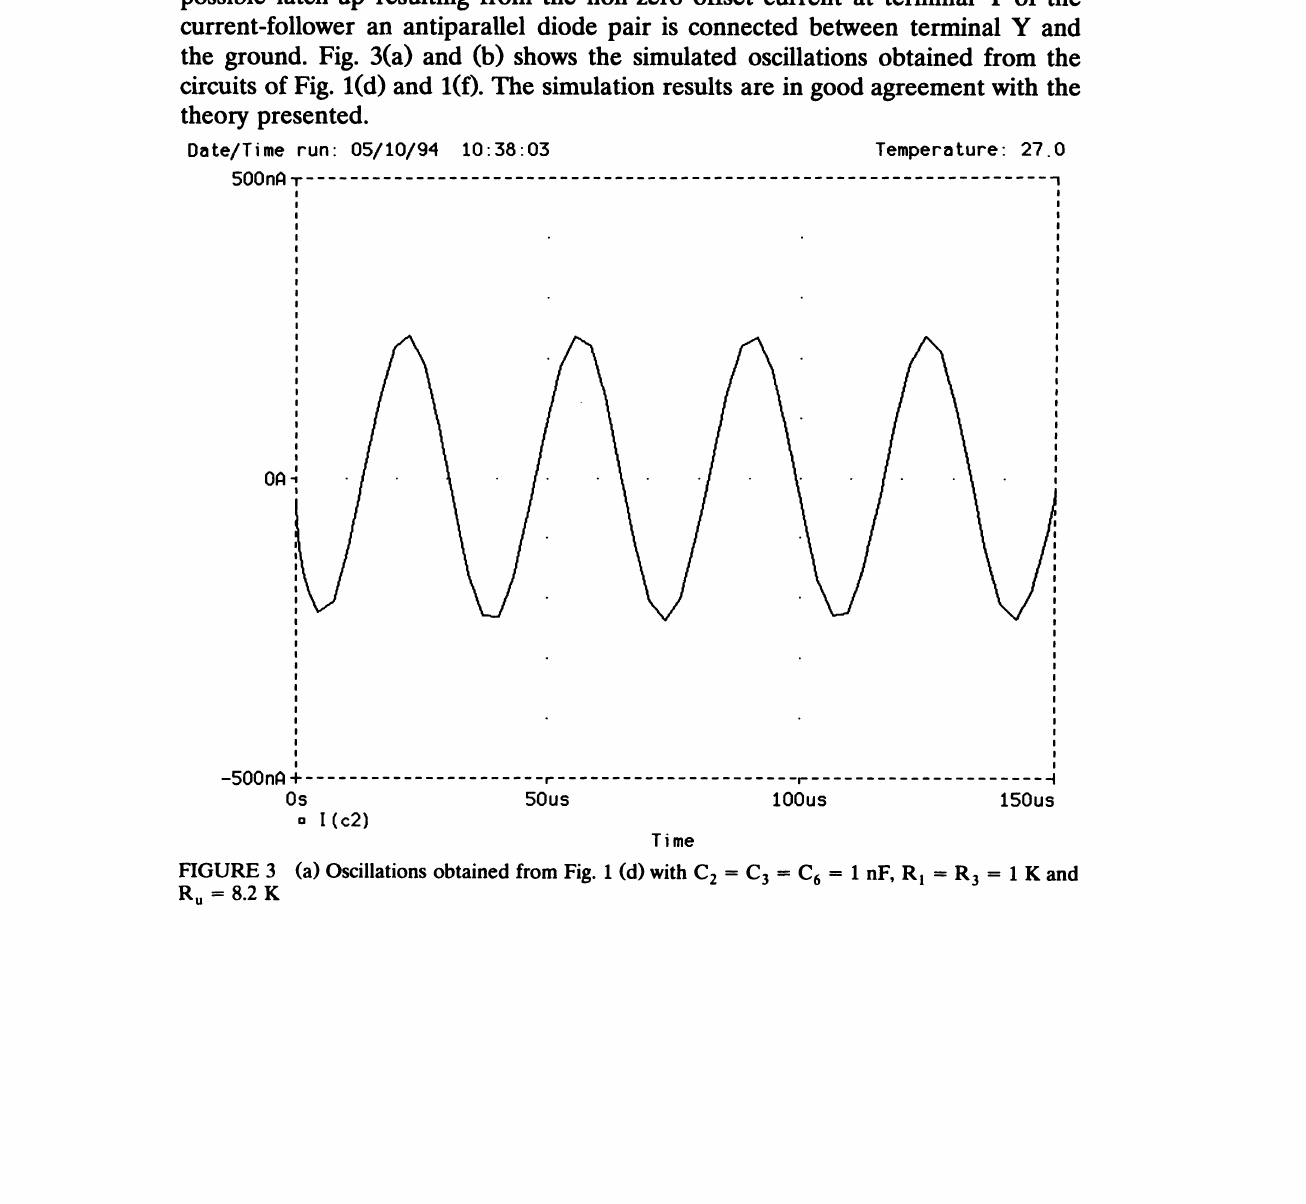
I(c2) FIGURE 3 (a) Oscillations obtained from Fig. (d)with C C3 Cti nF, R R K R 8.2 K